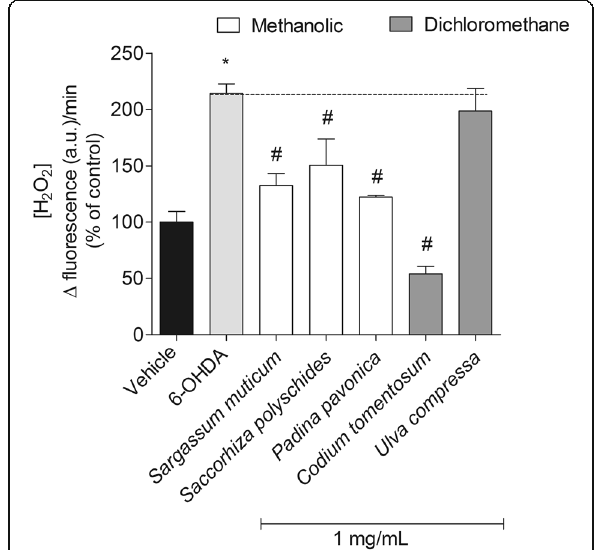
Fig. 4 Levels of hydrogen peroxide (H 2 O 2 ) produced by SH-SY5Y cells after 12 h of incubation with 6-OHDA (100 μ M) in presence or absence of seaweeds extracts (1 mg/mL). H 2 O 2 was quantified fluorimetrically using the “ ™ Amplex red hydrogen peroxide assay ” kit. Symbols represent statistically significant differences ( p <0.05, ANOVA, Dunett ’ s test) when compared to: * vehicle. # to